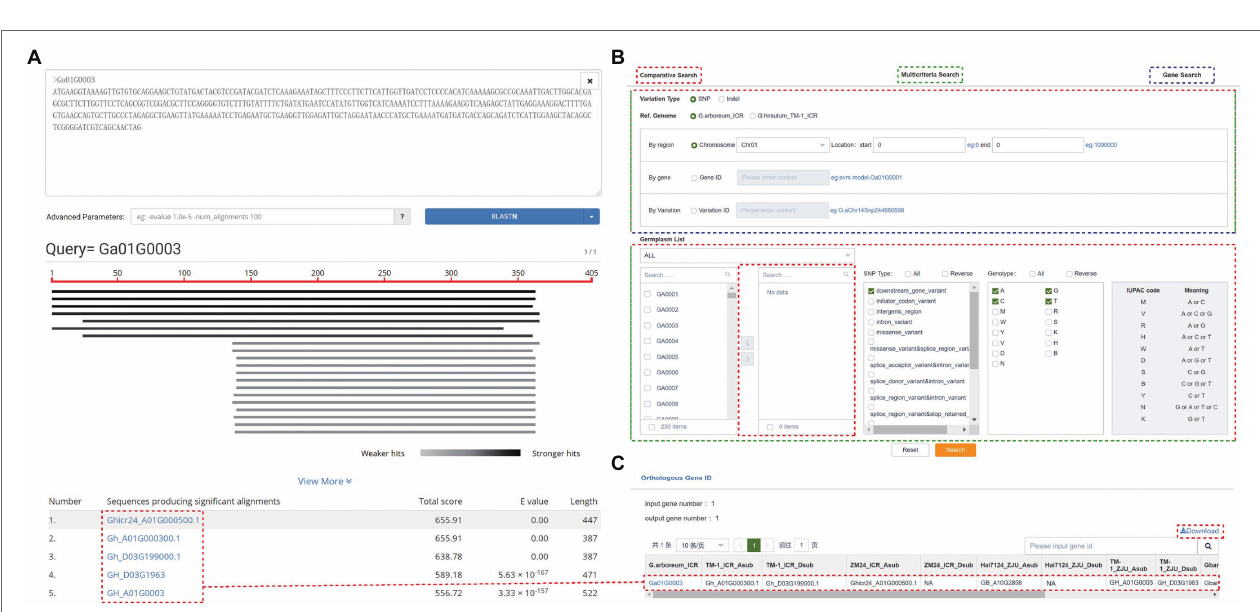
FIGURE 2 | An example of a gene page showing multiple types of information associated with the gene. (A) The annotation information of gene “ Gh_ D03G071700 .” (B) the gene “ Gh_D03G071700 ” is annotated as the hAT family C-terminal dimerization region and can be also found at the end page by searching the gene family function panel with PF05699. (C) The SNP Variation or INDEL Variation analyzes the genomic variation data (SNP or INDEL) on each chromosome of a group of individuals. (D,E) The Gbrowse and Jbrowse page.